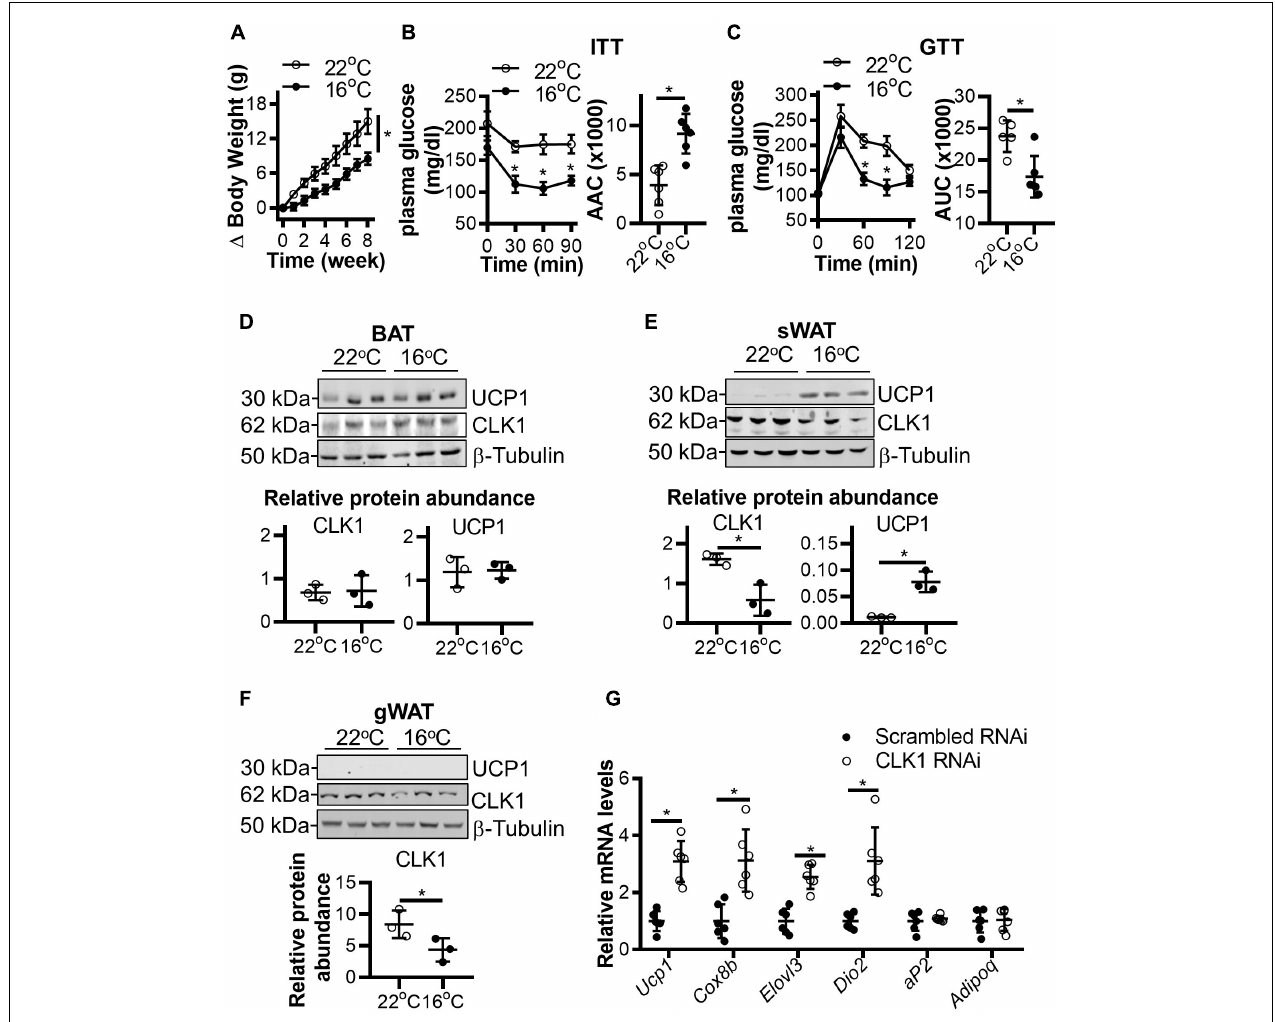
FIGURE 2 | CLK1 downregulation in adipose tissues is associated with insulin sensitivity in mice housed in a mild cold environment. (A) The body weight change of 8-week-old male mice being fed a high-fat diet (HFD) for 8 weeks while housed in either 22 or 16 ◦ C environmental chambers. n = 6/group, data shown as mean ± SEM, * p < 0.05 vs 22 ◦ C. (Two-way ANOVA with Sidak’s multiple comparisons test). (B) The insulin tolerance test (ITT) and (C) glucose tolerance test (GTT) in mice from panel (A) at the end of the 8-weeks of HFD feeding. Histograms show the corresponding areas above the curves (AAC) of ITT, and areas under the curves (AUC) of GTT. n = 6/group, data shown as mean ± SEM, * p < 0.05 vs 22 ◦ C. (Two-way ANOVA with Sidak’s multiple comparisons test). (D–F) The protein abundance of CLK1 and UCP1 in BAT (D) , sWAT (E) , and gWAT (F) in mice from panel (A) at the end point of the 8-week HFD feeding. The lower panels are the quantitative data of the corresponding Western blots shown in the upper panels. n = 3/group, data shown as mean ± SD, * p < 0.05 vs 22 ◦ C. (Unpaired Student’s t test). (G) The mRNA levels (relative to 18S rRNA) of browning markers in immortalized mouse brown adipocytes, originally isolated from mice on chow diet, and subjected to Clk1 knockdown or siRNA control (10 nM) on day 5 of differentiation and treatment at differentiation day 7 with 10 mM CL316,243 for 24 h. n = 3, data shown as mean ± SD, * p < 0.05 vs scrambled RNAi control. (Unpaired Student’s t